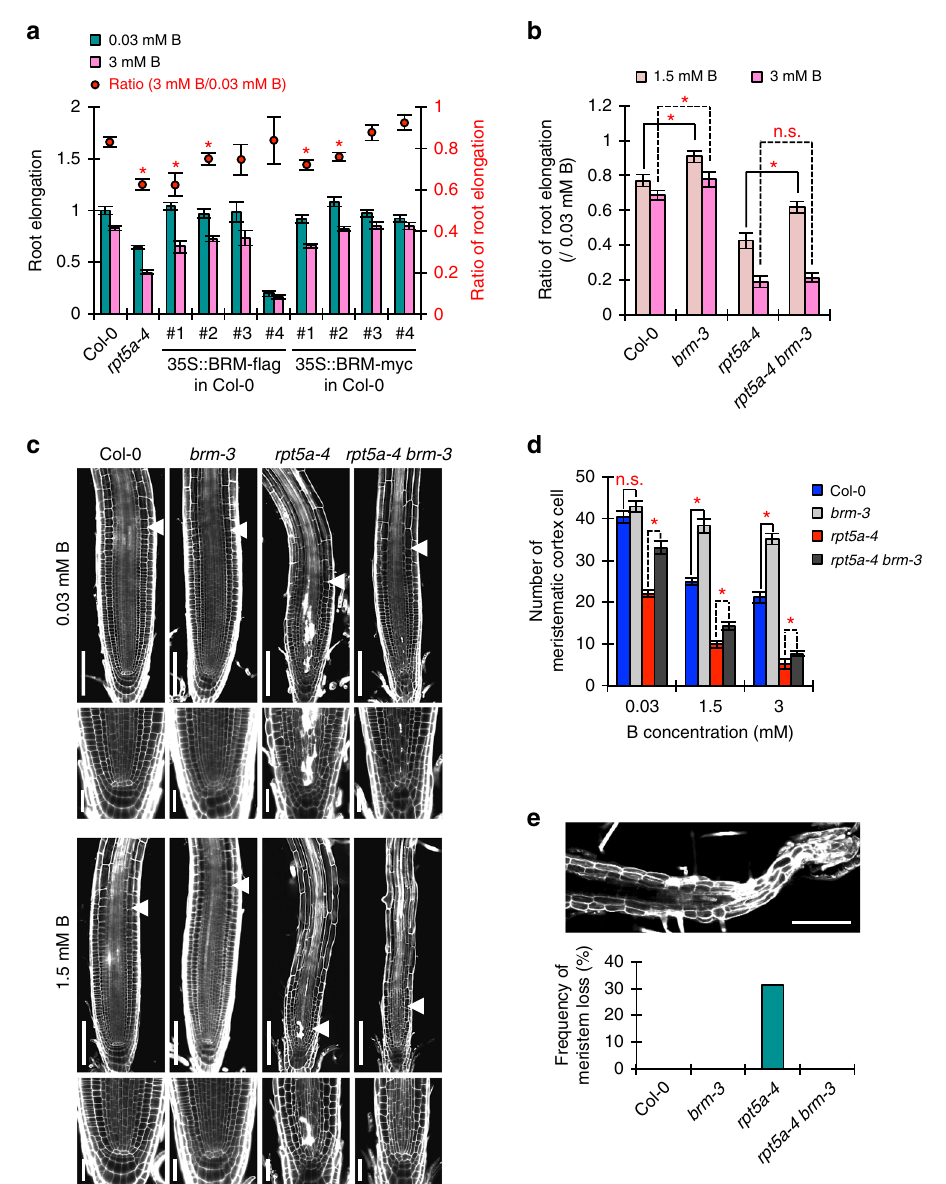
Fig. 7 Regulation of BRM levels through the 26SP containing RPT5a is crucial for RAM maintenance under high-B conditions. a Sensitivity of root growth of Col-0, rpt5a-4 , and transgenic plants showing enhanced BRM expression to high-B stress. Values for root elongation are ratios relative to the value of Col-0 under 0.03 mM B conditions. Red circles represent the ratio relative to the value under 0.03 mM B conditions ( n = 10 – 17, average ± s.e.m.; * P < 0.05, compared with Col-0, Student ’ s t -test). b Sensitivity of Col-0, brm-3 , rpt5a-4 , and rpt5a-4 brm-3 root growth to high-B stress. Values are ratios relative to the values at 0.03 mM B ( n = 15 – 16, average ± s.e.m.; * P < 0.05, Student ’ s t -test). c Representative images of root morphology of Col-0, brm-3 , rpt5a-4 , and rpt5a-4 brm-3 treated with normal- and high-B for 7 days. Arrowheads indicate the border between the meristem and elongating region. Below are magni fi ed images of the stem cell niche. Scale bars, 50 µ m. d Effect of high-B stress on the number of cortex cells in the RAM of Col-0, brm-3 , rpt5a-4 , and rpt5a-4 brm-3 ( n = 15 – 22, average ± s.e.m.; * P < 0.05, Student ’ s t -test). e Meristem loss speci fi cally observed in rpt5a-4 with long-term (7 days) treatment of 3 mM B. Upper panel shows a representative image of a rpt5a-4 root with meristem loss. Lower panel shows the frequency of meristem loss in Col-0, brm-3 , rpt5a-4 , and rpt5a-4 brm-3 under 3 mM B conditions, which were evaluated using same data sets used in d ( n = 15 –